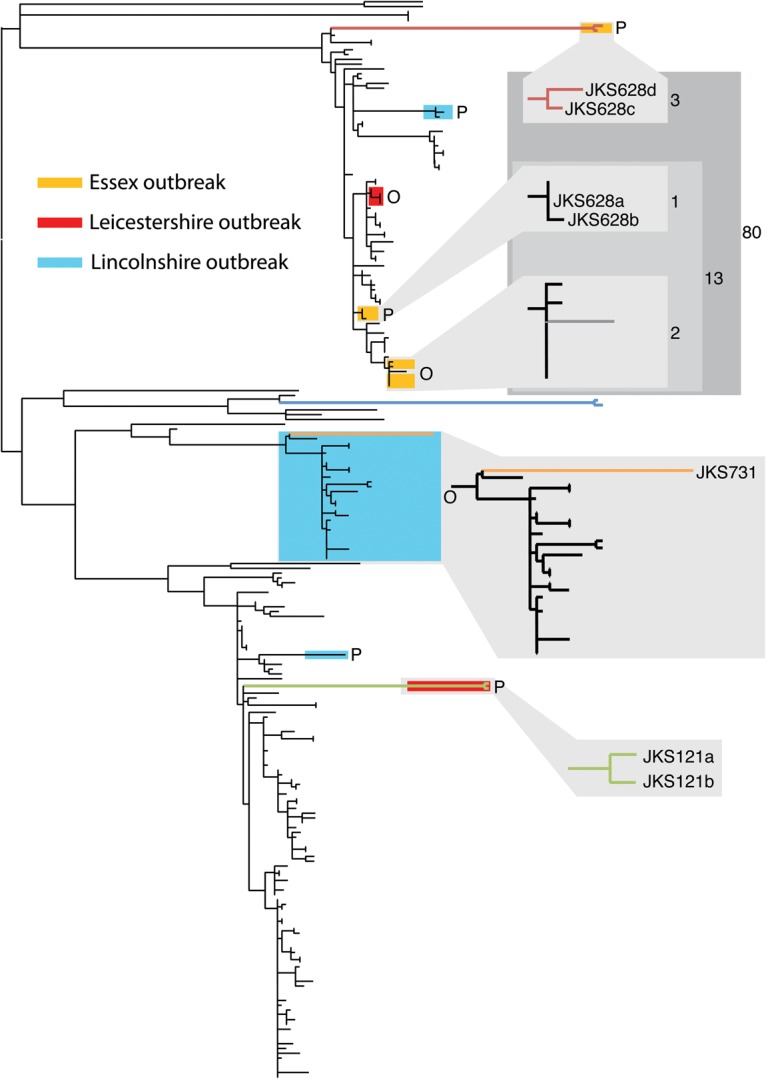
Detailed epidemiology of three S. equi outbreaks in the United Kingdom. Isolates highlighted on the phylogeny were collected from three stables experiencing strangles outbreaks, as indicated by the key. In each case, isolates did not fall into single clades on the phylogeny; instead they were grouped into outbreak (O) and persistent (P) clusters. The positions of the outlier branches identified by root-to-tip analysis are labeled in blowups of the relevant clades. For the Essex outbreak, the number of SNPs within and between clades is indicated by the numbers in the gray boxes. Colored branches in the tree correspond to those in Figure 1.